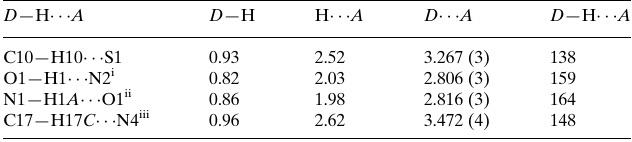
Hydrogen-bond geometry (A˚ , (cid:2)